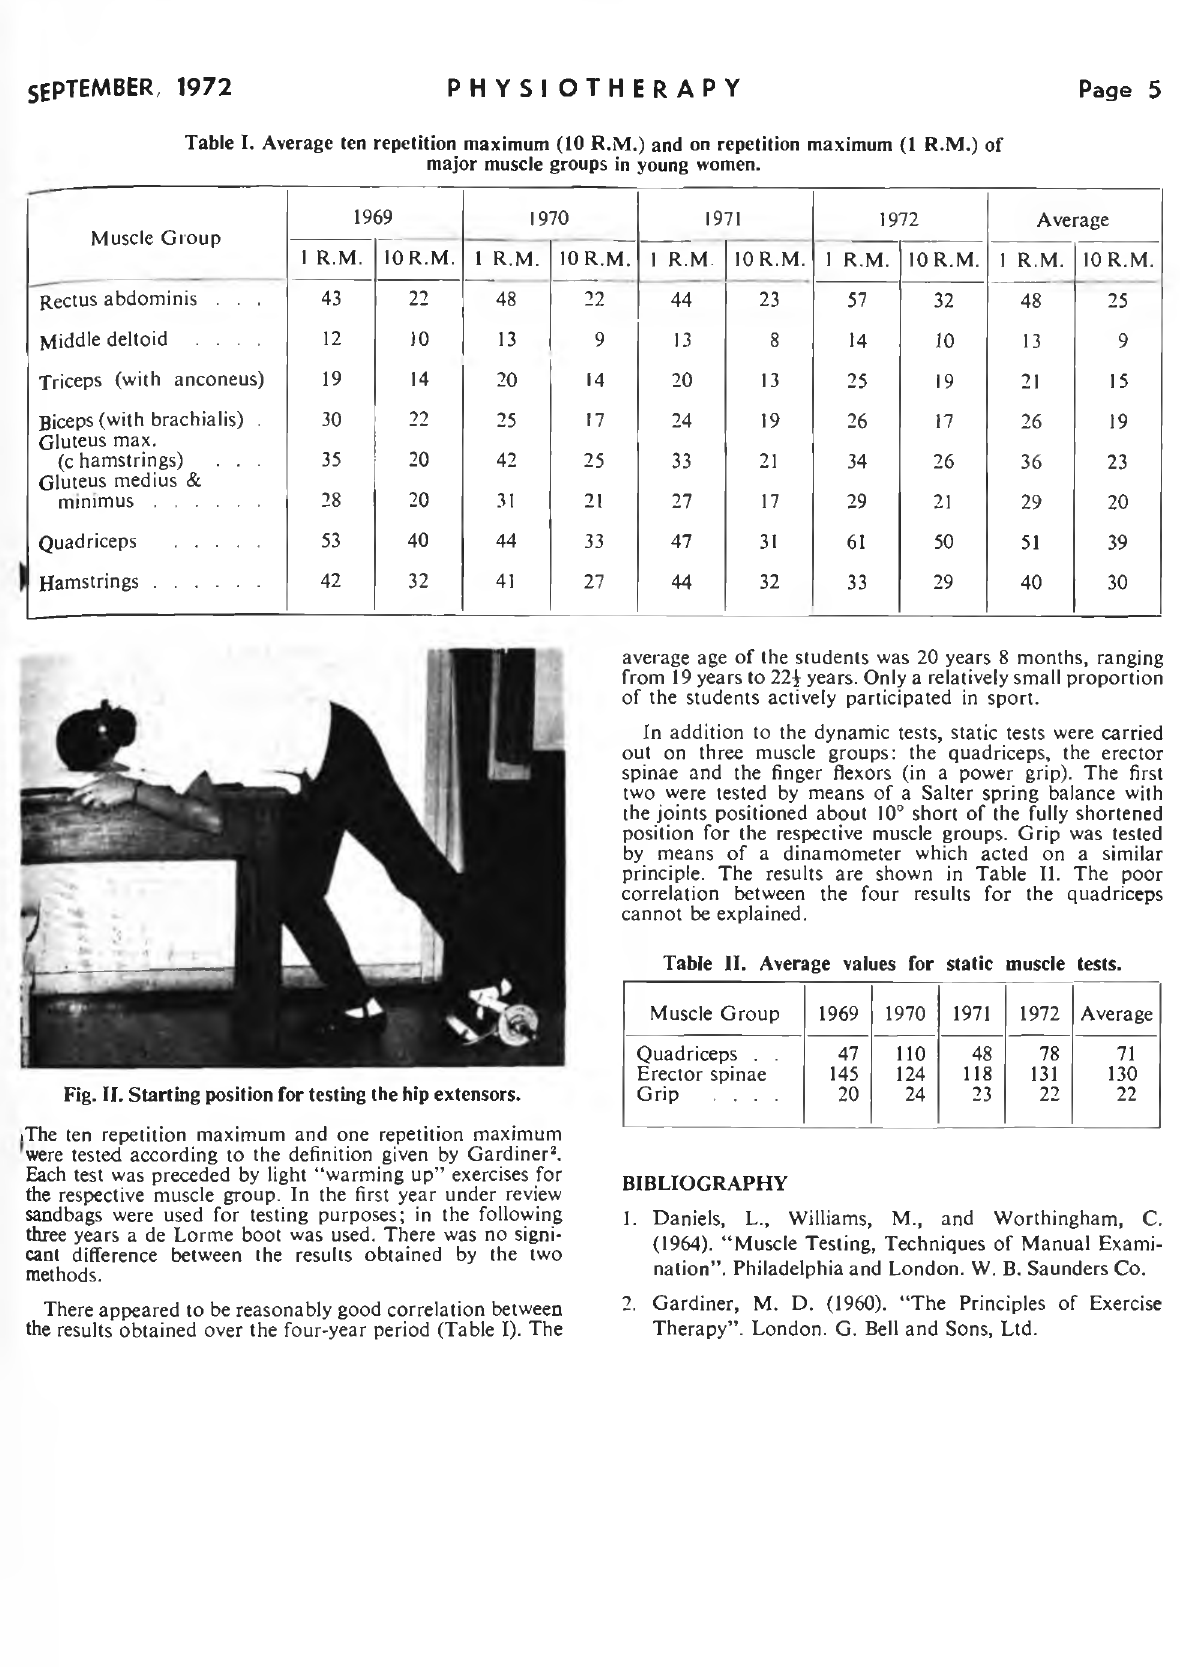
Fig. II. Starting position for testing the hip extensors.